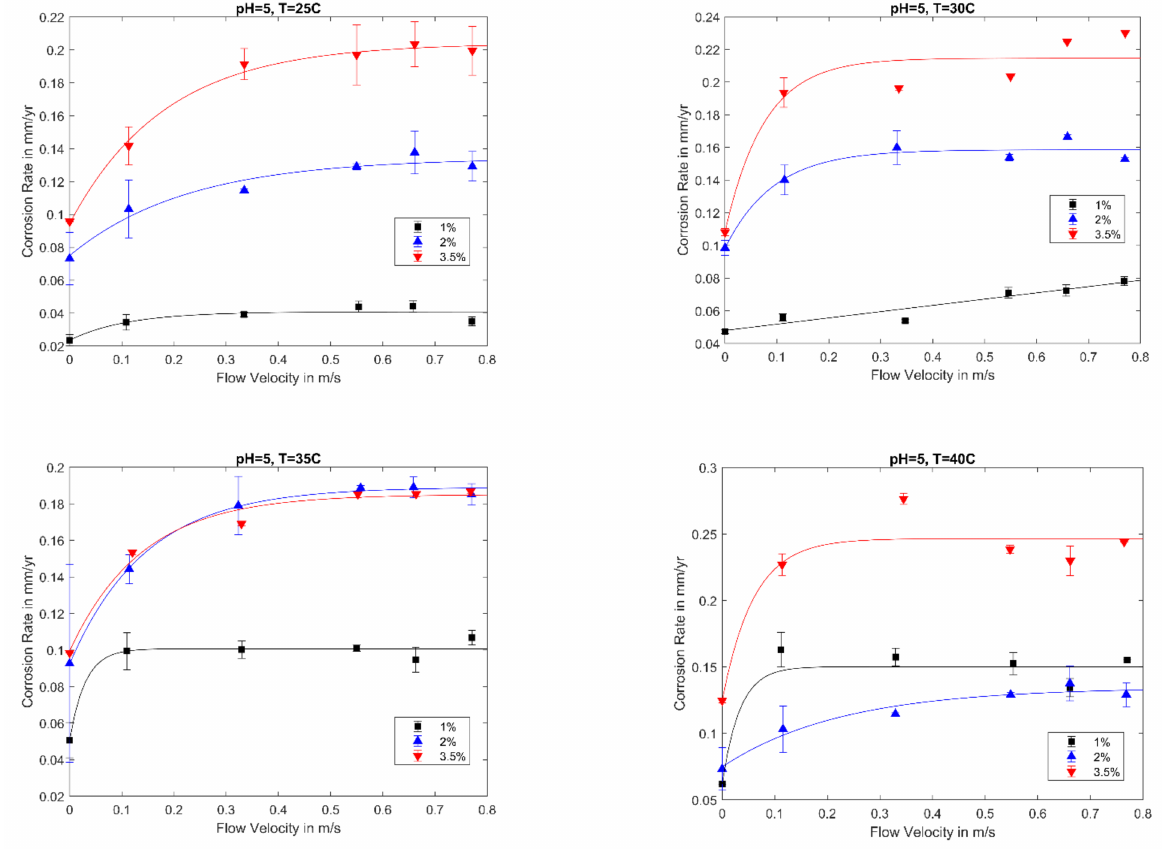
Figure 9. Corrosion rates of API-5L-X65 QT are shown at different flow velocities for feed solution maintained at pH-5 varying NaCl concentrations and temperatures (25 ◦ C, 30 ◦ C, 35 ◦ C, and 40 ◦